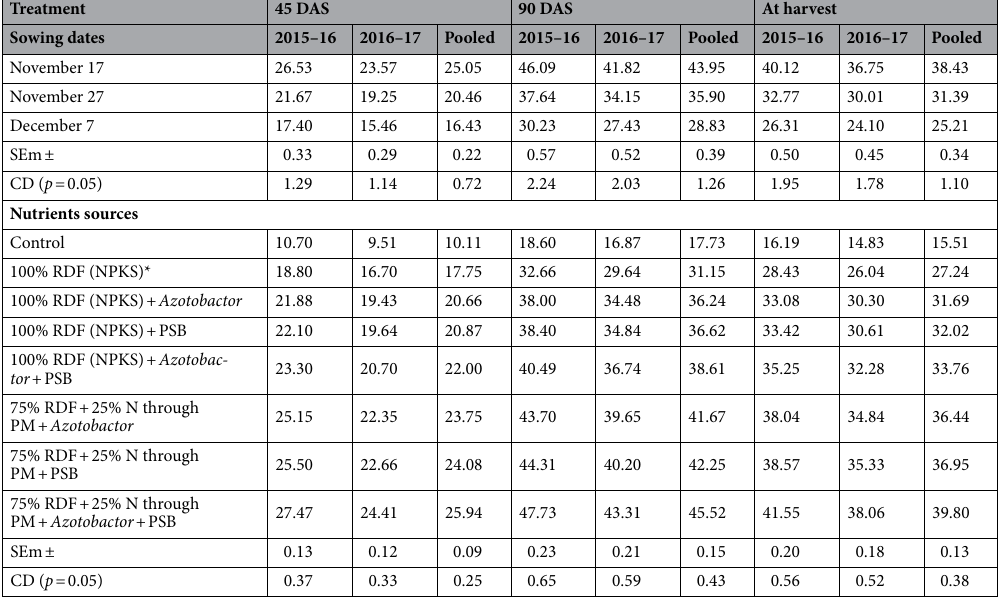
Table 2. Effect of sowing dates and nutrient sources on fungi (× 10 5 CFU g −1 soil) population of Indian mustard.